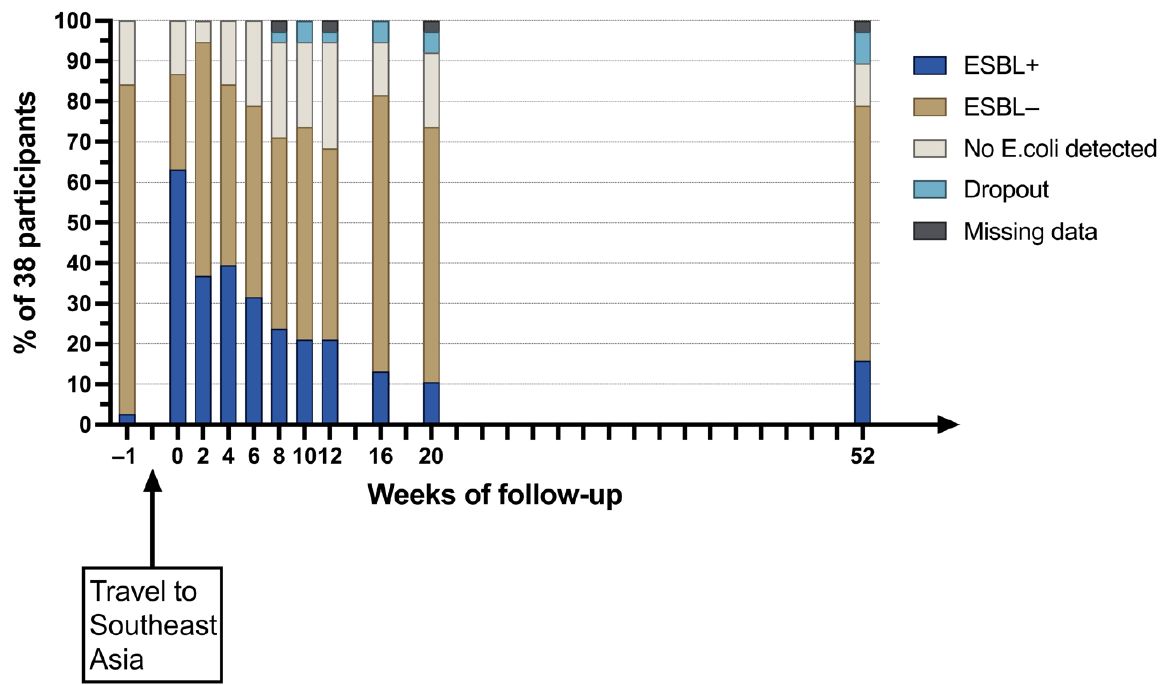
Figure 4. Preliminary results on colonization status during follow-up (see Supplementary File 8).